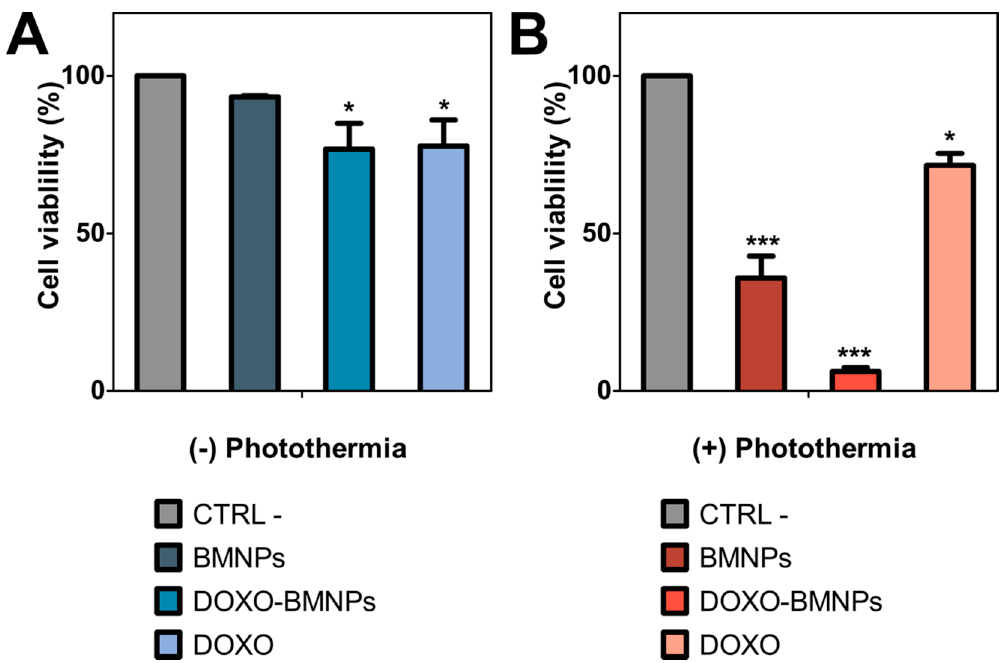
Figure 5. HepG2 cell viability with and without photothermia treatment in vitro. Cell viability was assessed with the resarzurin assay without ( A ) and after photothermia treatment with NIR-laser power of 2 W cm − 2 for 600 s ( B ). p ≤ 0.05 (*) and p ≤ 0.001 (***).